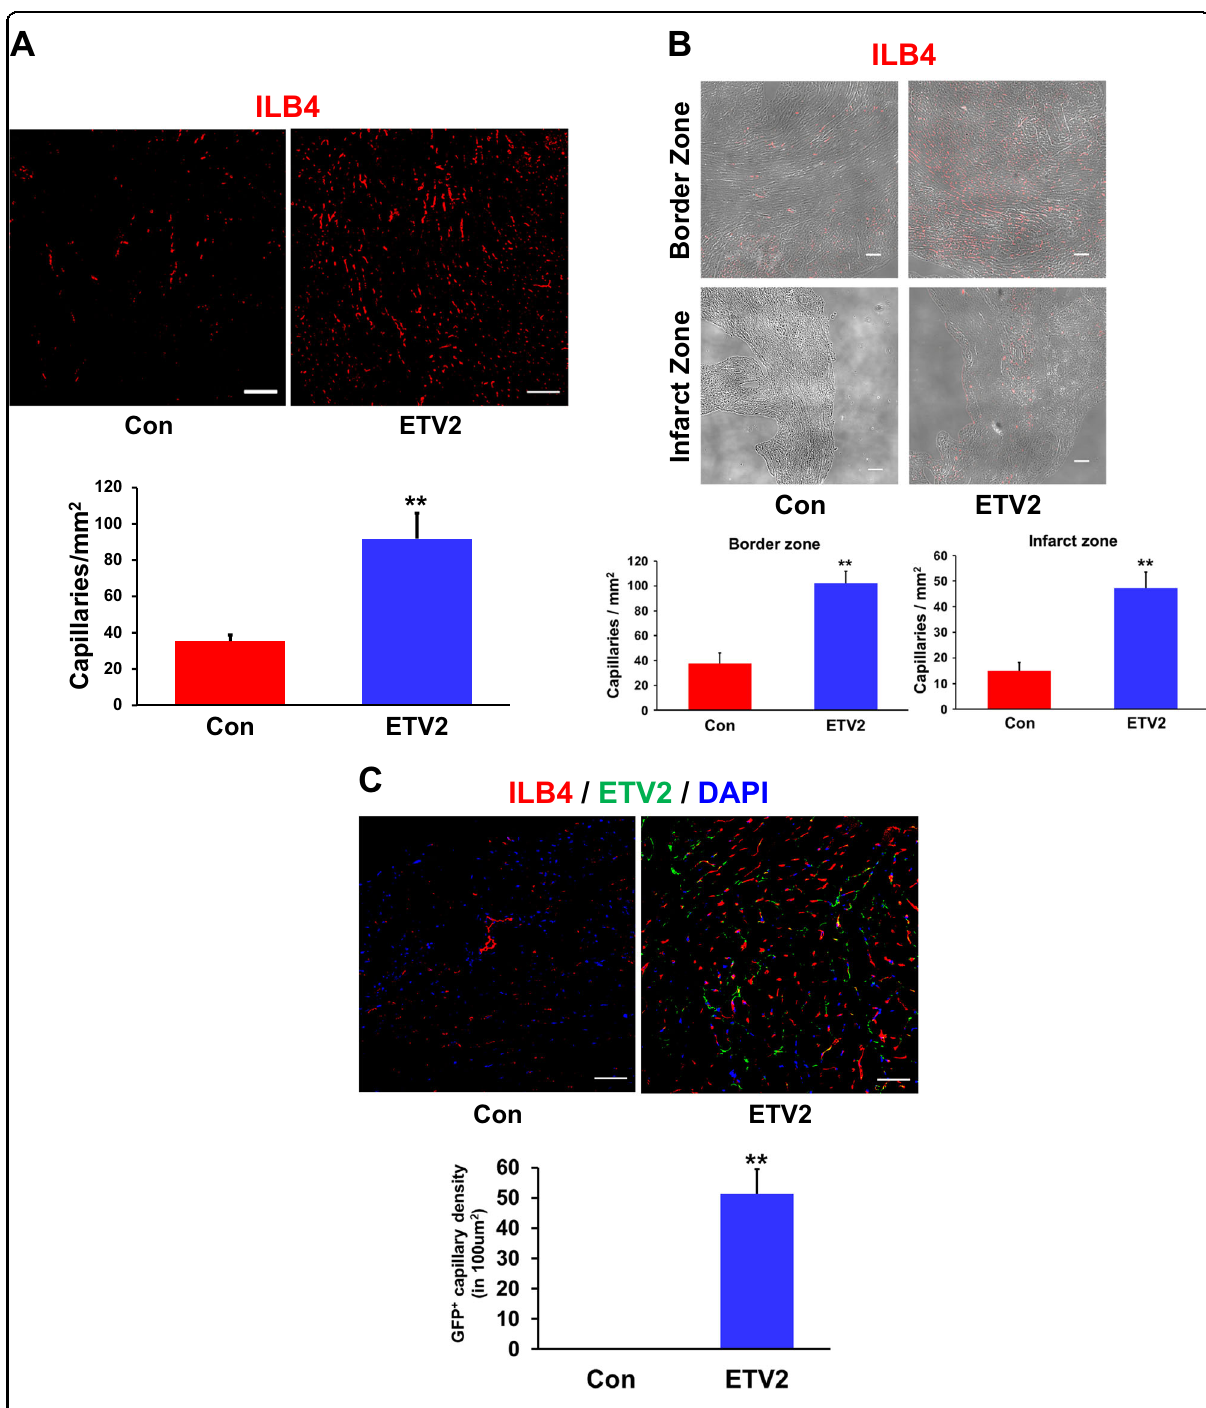
Fig. 4 ETV2 overexpression increases capillary density in MI hearts. MI hearts of mice receiving lentiviral particles of ETV2-Ires-VENUS or VENUS were perfused with rhodamine conjugated IB4 to visualize vessels. They were subjected to immunohistochemical staining with anti-GFP antibody, IB4 (red), ETV2 (green), and DAPI for nuclei (blue). a Representative images of capillaries 8 weeks after MI (upper panels) and summarized quanti fi cation (lower panels), scale bars: 100 µm. For quanti fi cation, the number of capillaries in fi ve randomly selected fi elds in each heart was counted, n = 5 – 7. b Representative images of capillaries (upper panels) and summarized quanti fi cation (lower panels) in the border zone and infarct zone in individual test groups, scale bars: 100 µm. n = 5. c A signi fi cant number of vessels were double-positive for both IB4 (red) and ETV2 (green) in ETV2-injected heart tissues. Representative confocal images of double-positive capillaries (upper panels) and summarized quanti fi cation (lower panels) in heart tissue harvested 8 weeks after ETV2 injection, scale bars: 50 µm. * p < 0.05, ** p < 0.01 compared to control